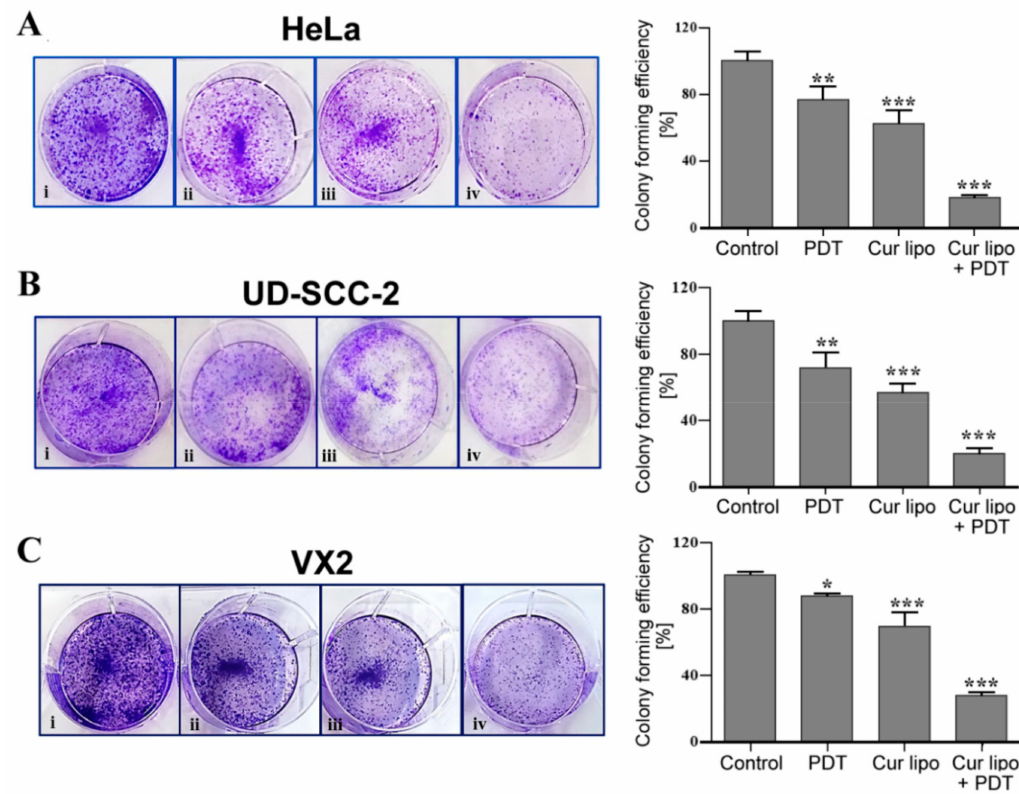
Figure 5. Colony formation assay with HeLa, UD-SCC-2, and VX2 cells. HeLa ( A ), UD-SCC-2 ( B ), and VX2 ( C ) cells were exposed to photodynamic therapy (PDT) only ( ii ), curcumin liposomes (Cur lipo) only ( iii ), or Cur lipo in combination with PDT ( iv ). Untreated cells were used as a control ( i ). Cell colonies of HeLa ( A ), UD-SCC-2 ( B ), and VX2 ( C ) cells were stained with 0.1% crystal violet dye. Graphical data represent the level (percentage) of colony formation after exposure to the various treatment modalities compared to control values. Values are presented as the mean ± standard deviation, and statistical significances are indicated as *** p < 0.001, ** p < 0.01, * p <